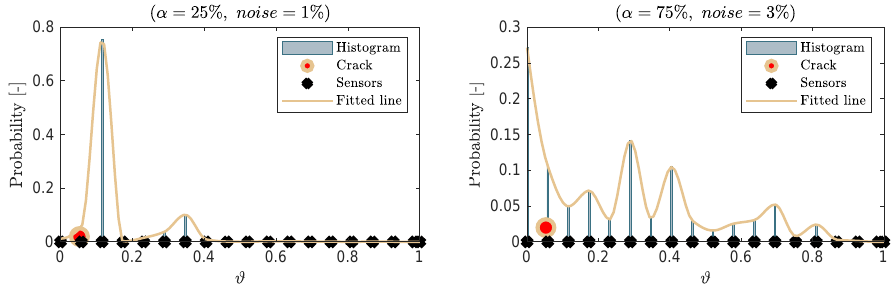
Figure 15. Localizing the damage ˆ ϑ using the curvature algorithm: for ϑ = 0.05, α = 25%, noise = 1%, and d sn = 0.05 ( left ); for ϑ = 0.05, α = 75%, noise = 3%, and d sn = 0.05 ( right